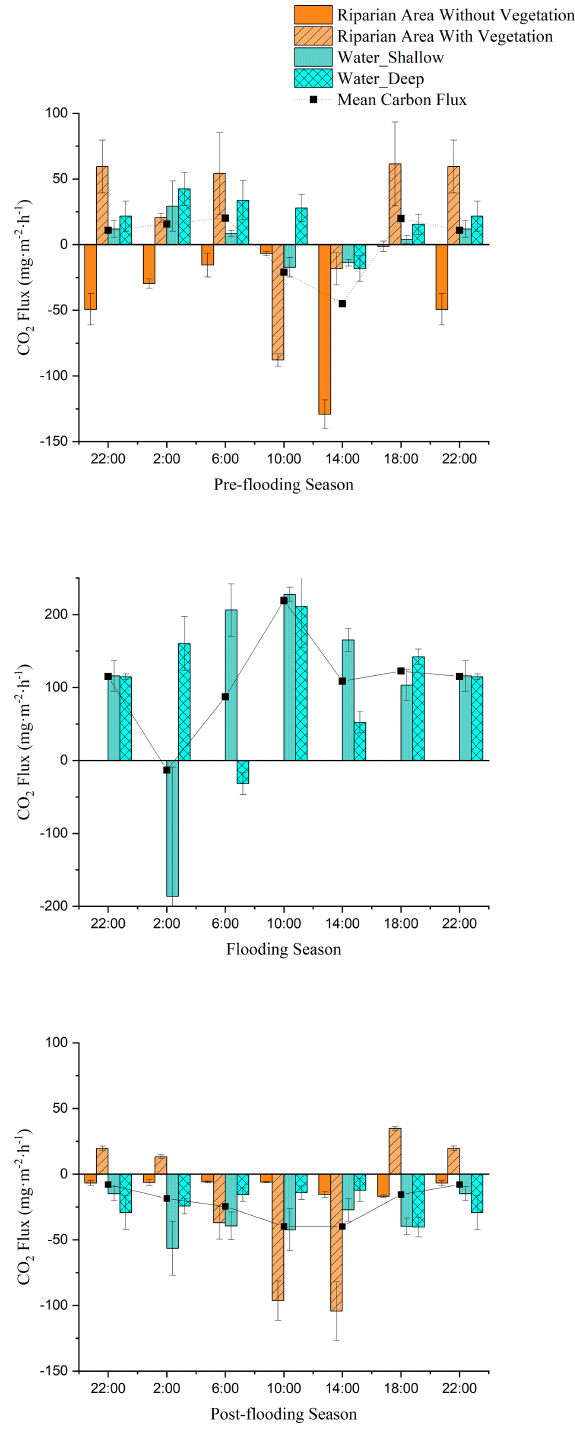
Figure 1. CO 2 fluxes in the riparian area (with vegetation and with- out vegetation) and fluvial area (shallow area with vegetation and deep area without vegetation) during pre-flooding season (measured in April), flooding season (August), and post-flooding season (Oc-